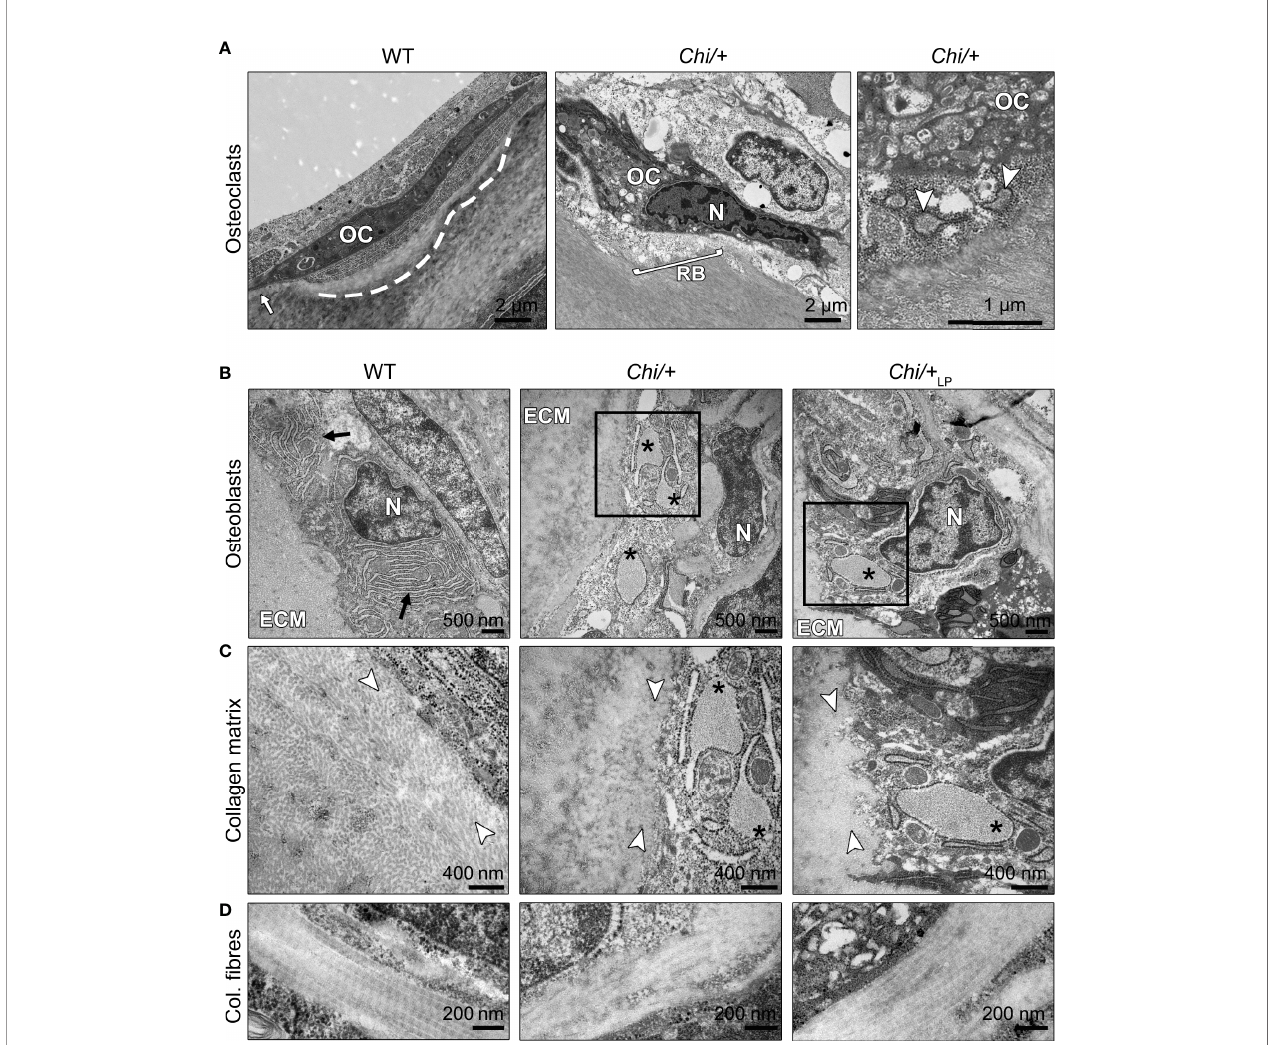
FIGURE 7 | Ultrastructure of bone cells and bone matrix in Chi/+ and Chi /+ LP animals. (A) Transmission electron microscopy (TEM) of osteoclasts (OC) located at the arch surface of three months old WT and Chi/+ (representative for both Chi /+ and Chi /+ LP ) vertebrae. The panel WT shows a typical fl at-shaped teleost osteoclast (OC) characterised by its electrodense cytoplasm. The cell resides in a shallow resorption lacuna (dashed line), yet is attached to the bone surface (white arrow). The panel Chi/+ shows an osteoclast that resorbs the bone matrix and exhibits the typical ‘ ruf fl ed border ’ (RB), an electron-dense cytoplasm with abundant cytoplasmic vacuoles and resorption vesicles (right panel, white arrowheads) in proximity of the ruf fl ed border. N, nucleus. (B) TEM of WT, Chi/+ and Chi /+ LP shows mutant osteoblasts with enlarged endoplasmic reticulum (ER) cisternae (asterisks). The osteoblasts are located in the growth zone of the vertebral body endplate (see Figure 3A for location). Higher magni fi cation images in (C) show that Chi/+ osteoblast ER cisternae are fi lled with protein, likely mutated collagen type I WT osteoblasts have numerous, yet not enlarged ER cisternae (arrows). ECM: extracellular matrix of the bone surface; N: nucleus. (C) The newly secreted collagen fi brils (white arrowheads) in the proximity of the osteoblasts in WT are visibly separated prior to maturation and assemblage into collagen fi bres. In contrast, the Chi/+ animal has densely packed collagen fi brils. No space can be recognised between the fi brils. In the Chi /+ LP individual collagen fi bres are densely packed and space between the fi brils is distinguishable in proximity to the osteoblasts. (D) Longitudinal sections of collagen fi bres show a regular D-periodicity pattern in a WT animal, absence D-period pattern in a Chi/+ mutant, and a less regular D-periodicity pattern a Chi /+ LP